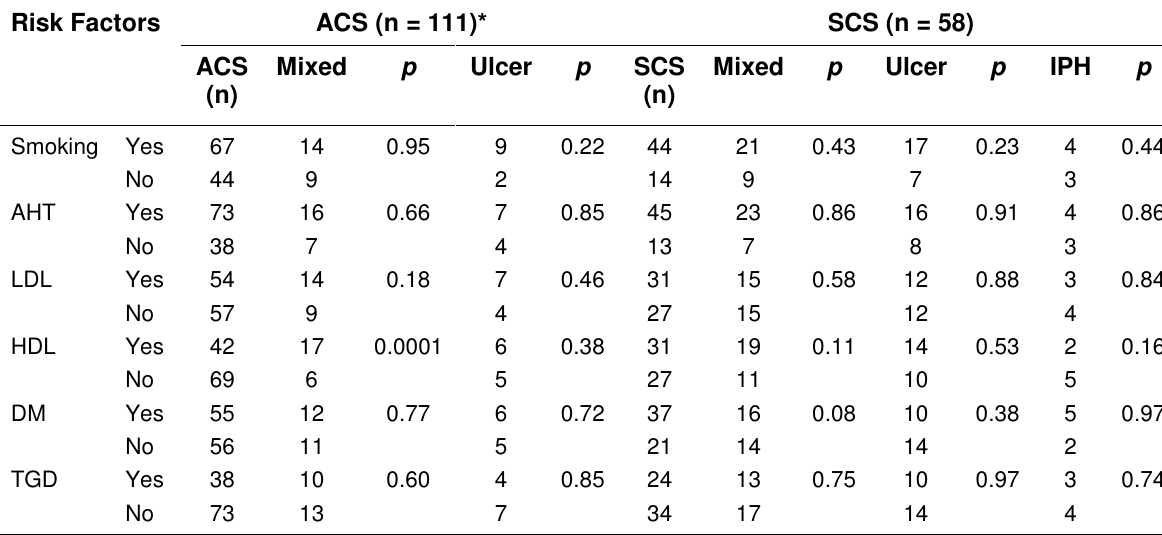
Association between the Risk Factors and Unstable Carotid Type Plaques